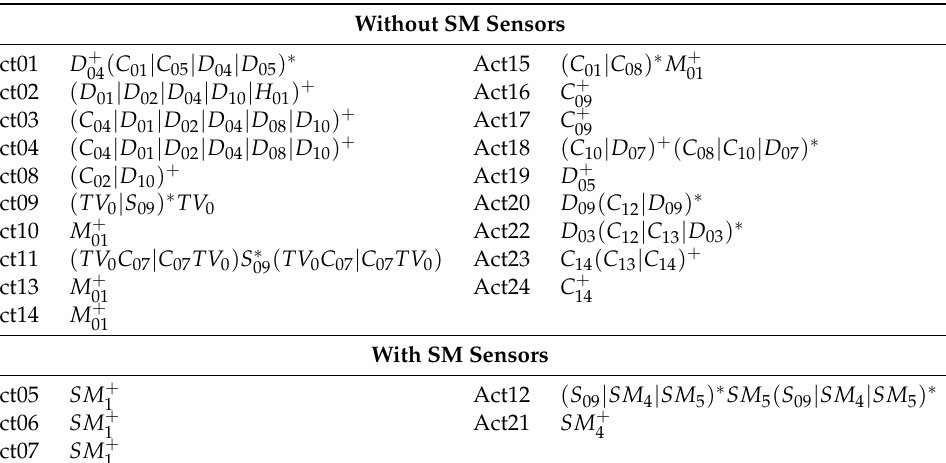
Table 3. Activities’ regular